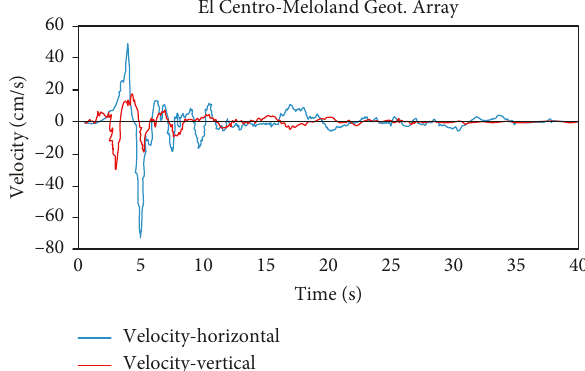
Figure 4: Velocity-time history of vertical and horizontal com- ponents of near-field earthquake with the effect of forward directivity.